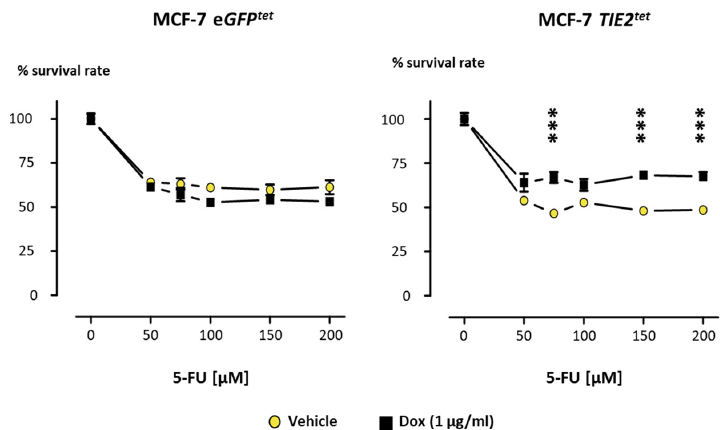
Figure 6. TIE2 expression increases the resistance to 5-Fluorouracil in MCF-7 cells. MCF-7 TIE2 tet and MCF-7 eGFP tet cells were cultured in the presence or absence of doxycycline (1 µg/mL) during 10 days of the experiment. 5-Fluorouracil (5-FU) was added to the cells for 4 days. Proliferation was assessed by MTT, and values are represented as the average ± SEM. *** p < 0.001 vs. vehicle-treated cells and analyzed using a two-way ANOVA with Bonferroni post-test.